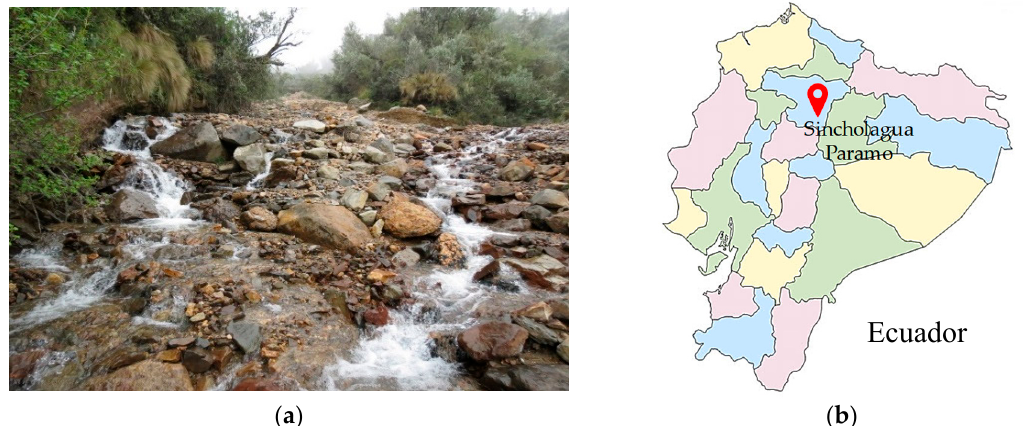
Figure 1. Mountain River at Sincholagua Paramo, Ecuador, approximately 4000 meters above sea level, MASL. ( a ) Type of solids transported by the river; ( b ) location in Ecuador (without scale).